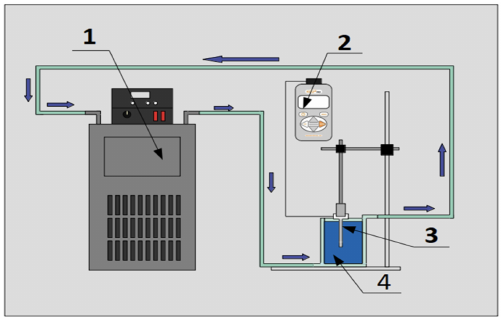
Figure 3. Experimental setup for thermal conductivity measurement. (1) Refrigerated circulating bath, (2) Decagon device property analyzer model KD2-Pro, (3) probe KS-1 and (4) sample in double jacketed beaker.